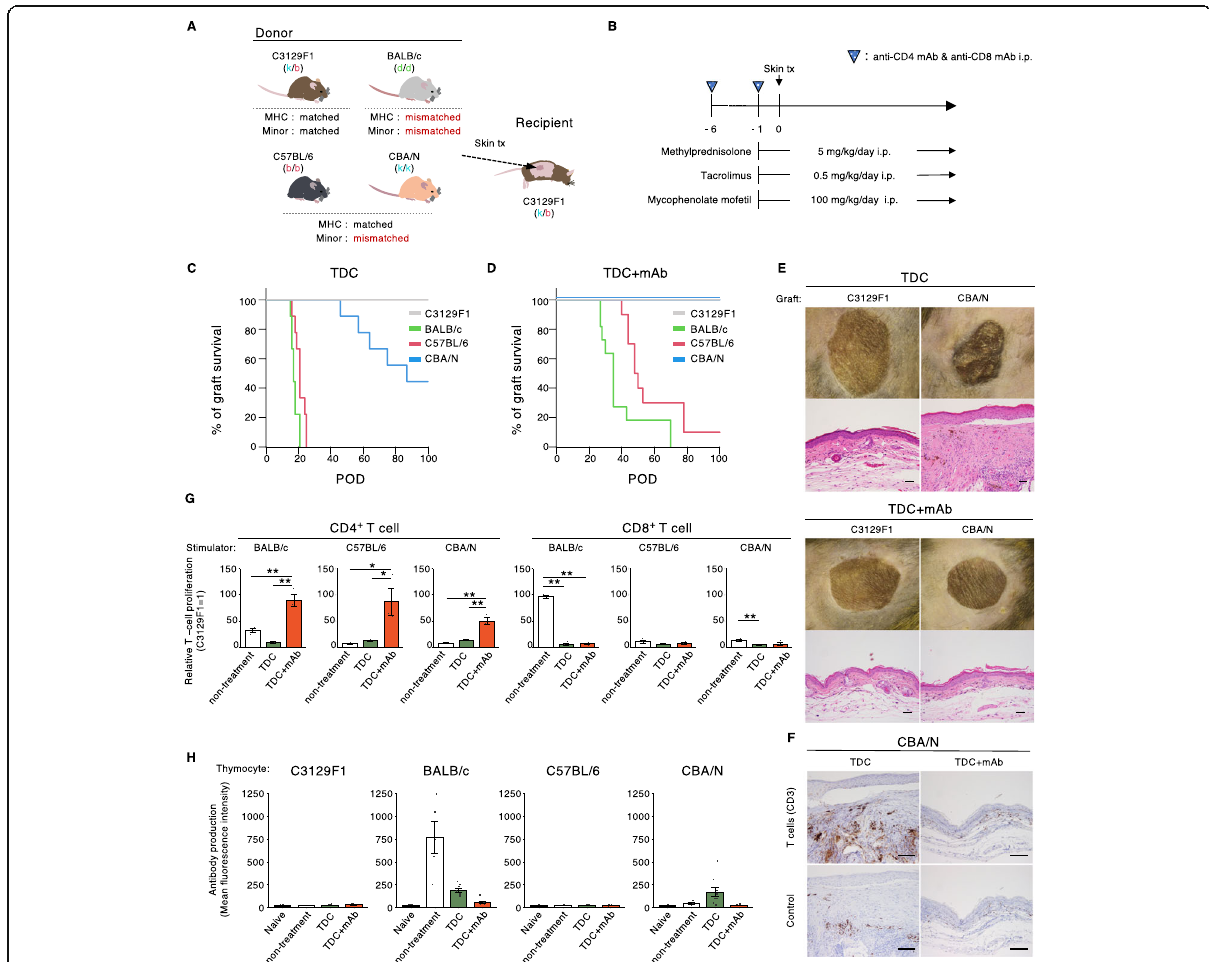
Fig. 1 Standard immunosuppressive therapy in solid organ transplantation has limited efficacy in mouse skin transplantation, even in MHC- matched situations. ( A ) Schematic overview of auto or allogeneic skin transplantation. ( B ) TDC-based immunoregulation protocol. Immunosuppression was performed by using a protocol of administrating a combination of methylprednisolone, tacrolimus, and mycophenolate mofetil daily (TDC) with or without anti-CD4 mAb and anti-CD8mAb on day 6 and 1 (TDC mAb). ( C ) Skin graft survival under immunosuppression with TDC ( n = 9, C3129F1; n = 9, BALB/c; n = 9, C57BL/6; n = 9, CBA/N). ( D ) Skin graft survival under immunosuppression with TDC + mAb ( n = 10, C3129F1; n = 11, BALB/c; n = 10, C57BL/6; n = 9, CBA/N). ( E ) Macroscopic observation (upper panels) and hematoxylin and eosin stained section (lower panels) of autologous (C3129F1) and CBA/N skin grafts on day 100. Scale bars: 100 μ m. ( F ) Immunohistochemical staining for CD3 of CBA/N skin grafts harvested from TDC or TDC + mAb treated groups on 100 days post-transplantation. Upper and lower panels represent CD3 specific staining and isotype control stained section, respectively. Scale bars: 100 μ m. ( G ) Recipient T cell response in MHC-matched but minor antigen-mismatched skin transplantation. The T cell proliferation rates in each treatment group were normalized to that of C3129F1 mice stimulated with autologous irradiated splenocytes. Error bars indicate standard error of technical triplicates. Similar results were obtained in two independent experiments. * p < 0.05, ** p < 0.01 (Tukey ’ s HSD test). ( H ) De novo anti-donor antibody production in the recipients. Error bars indicate standard error of biological replicates ( n = 8, naive; n = 4-5, non-treatment; n = 9, TDC; n = 7, TDC + mAb). tx, transplantation; mAb, monoclonal antibody; TDC, three drug combination; POD, post-operative